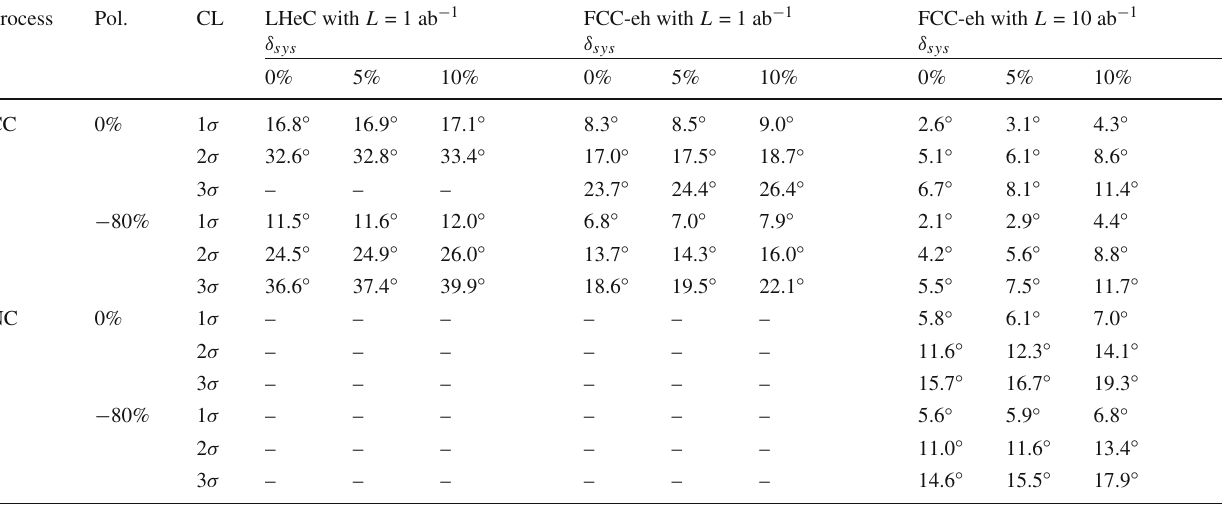
Table 2 Figure of meritdisplaying thelower limitson the mixingangle φ τ upto which the proposed LHeC and FCC-eh colliders can probe with 68%, 95% and 99.7% CL based on the χ 2 analysis for CC and NC